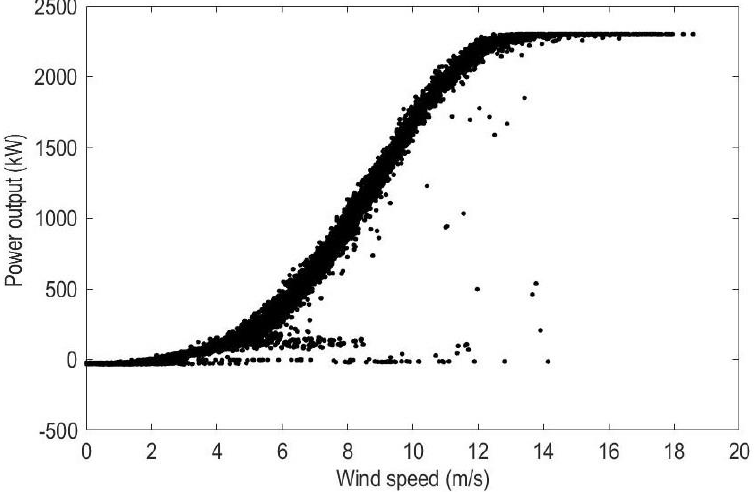
Figure 2. Raw power curve data .